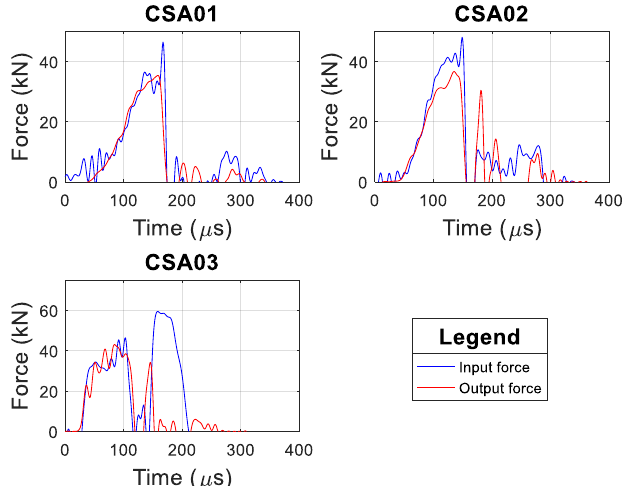
Figure 6. Experimentally measured input and output forces at the sample/bars interfaces in three dynamic experiments.